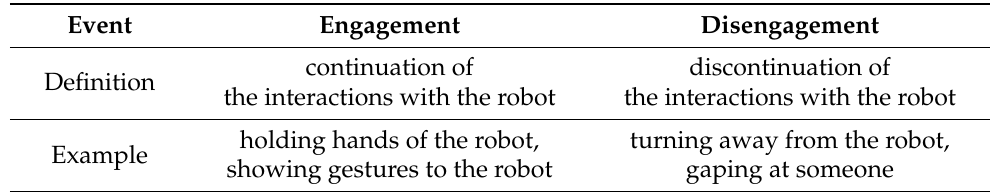
Table 2. Annotated events of engagement and